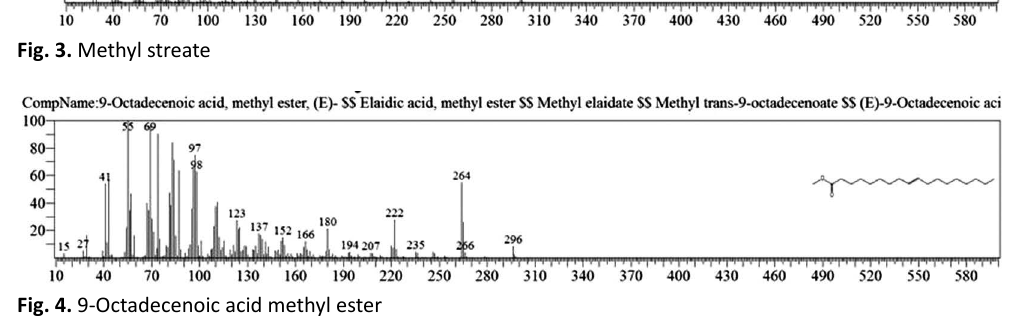
Fig. 3. Methyl streate